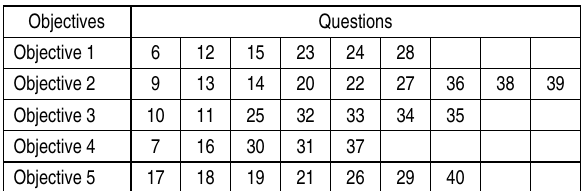
Table 4. Survey questions relating to each